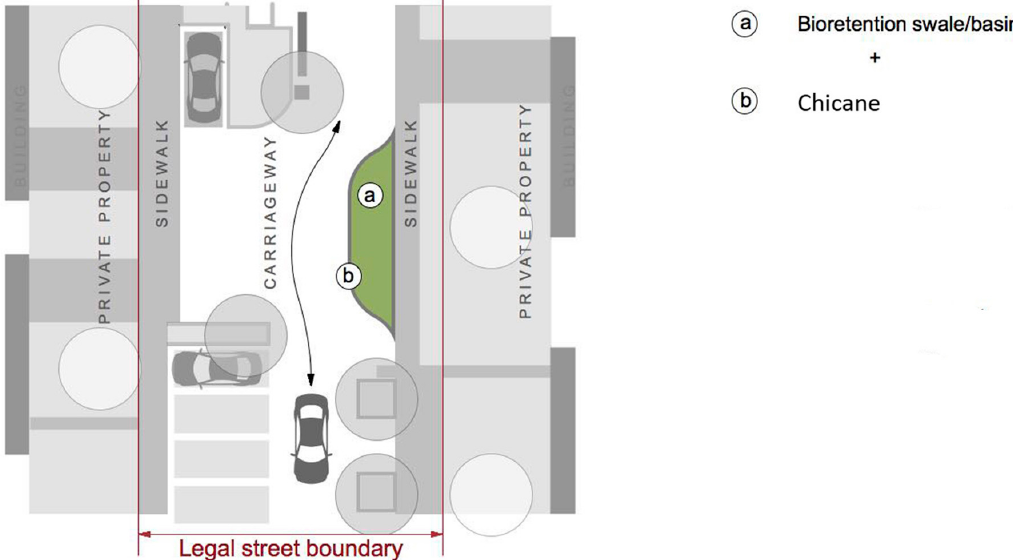
Figure 3. Example of physically integrated street infrastructure (plan view; not to scale).